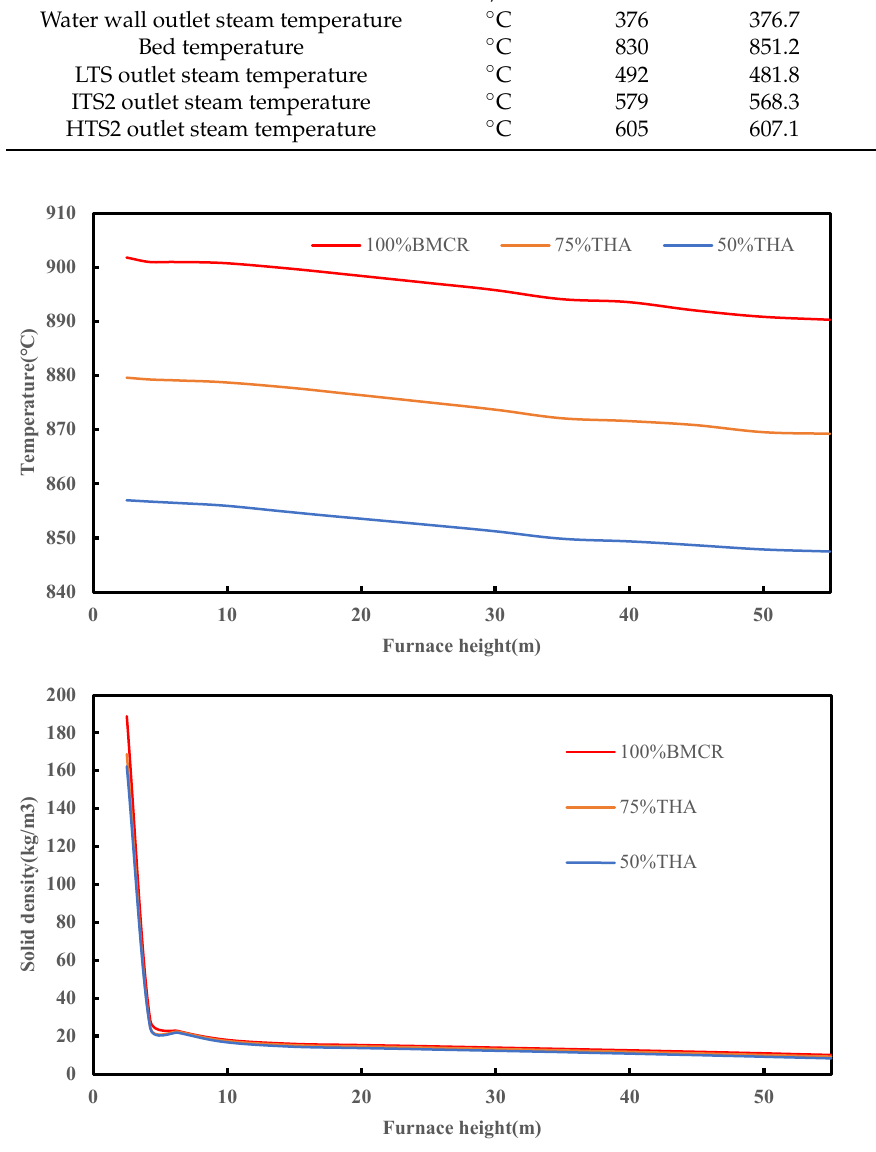
Figure 3. Temperature and solid density distribution in furnace at different conditions.